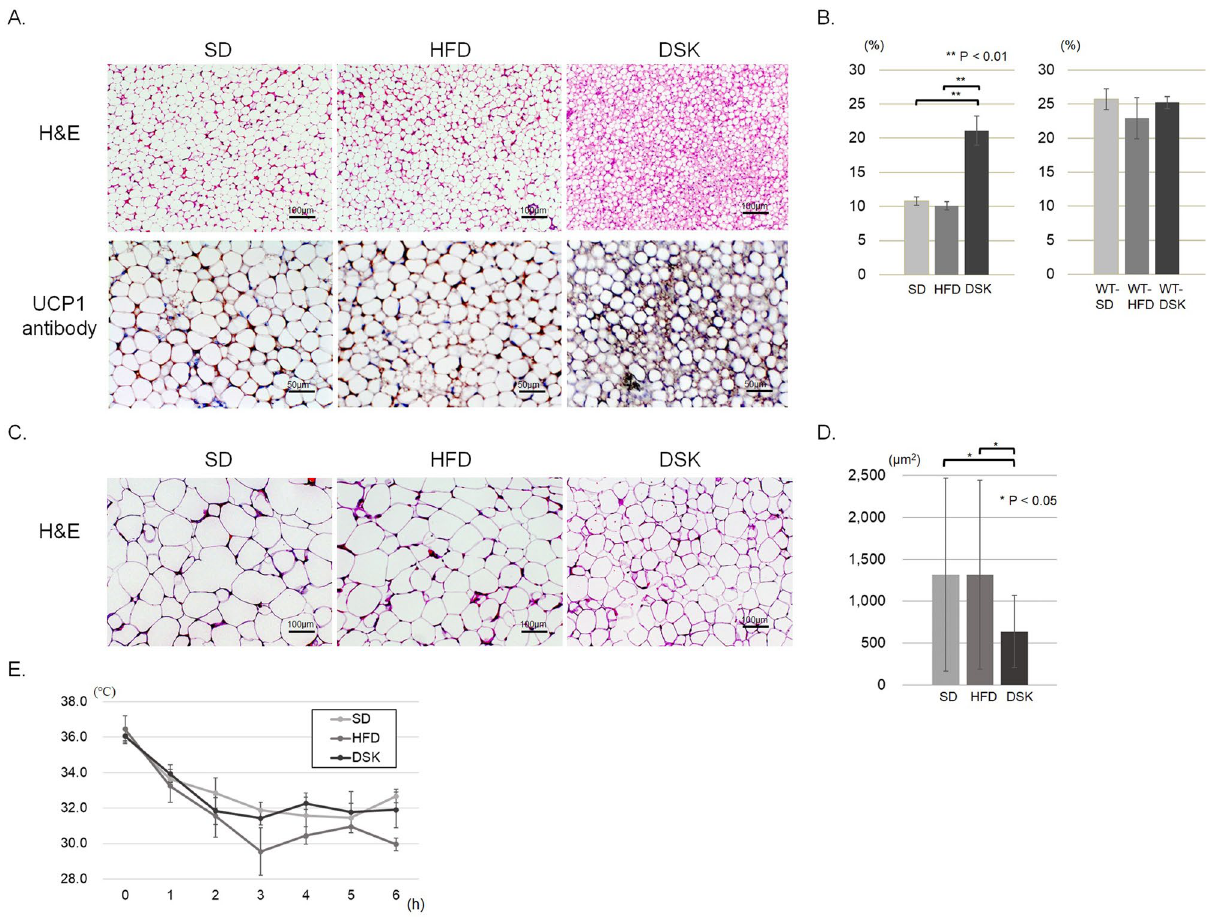
Figure 4. Effect of daisaikoto on energy expenditure via brown adipose tissue. The area of cytoplasm and UCP1 expression in MC4R-KO mice were significantly lower than those in the wild type mice, and that in the DSK group was significantly higher than those in the SD and HFD groups ( A,B , P < 0.01). In addition, size measurement of the cross-sectional area of white adipocytes in the visceral fat showed a significant reduction in the DSK group compared with the HFD group ( C,D , P < 0.01). Furthermore, the cold tolerance test indicated that the body temperature of the HFD group was lower than that of the other two groups after 6 h of